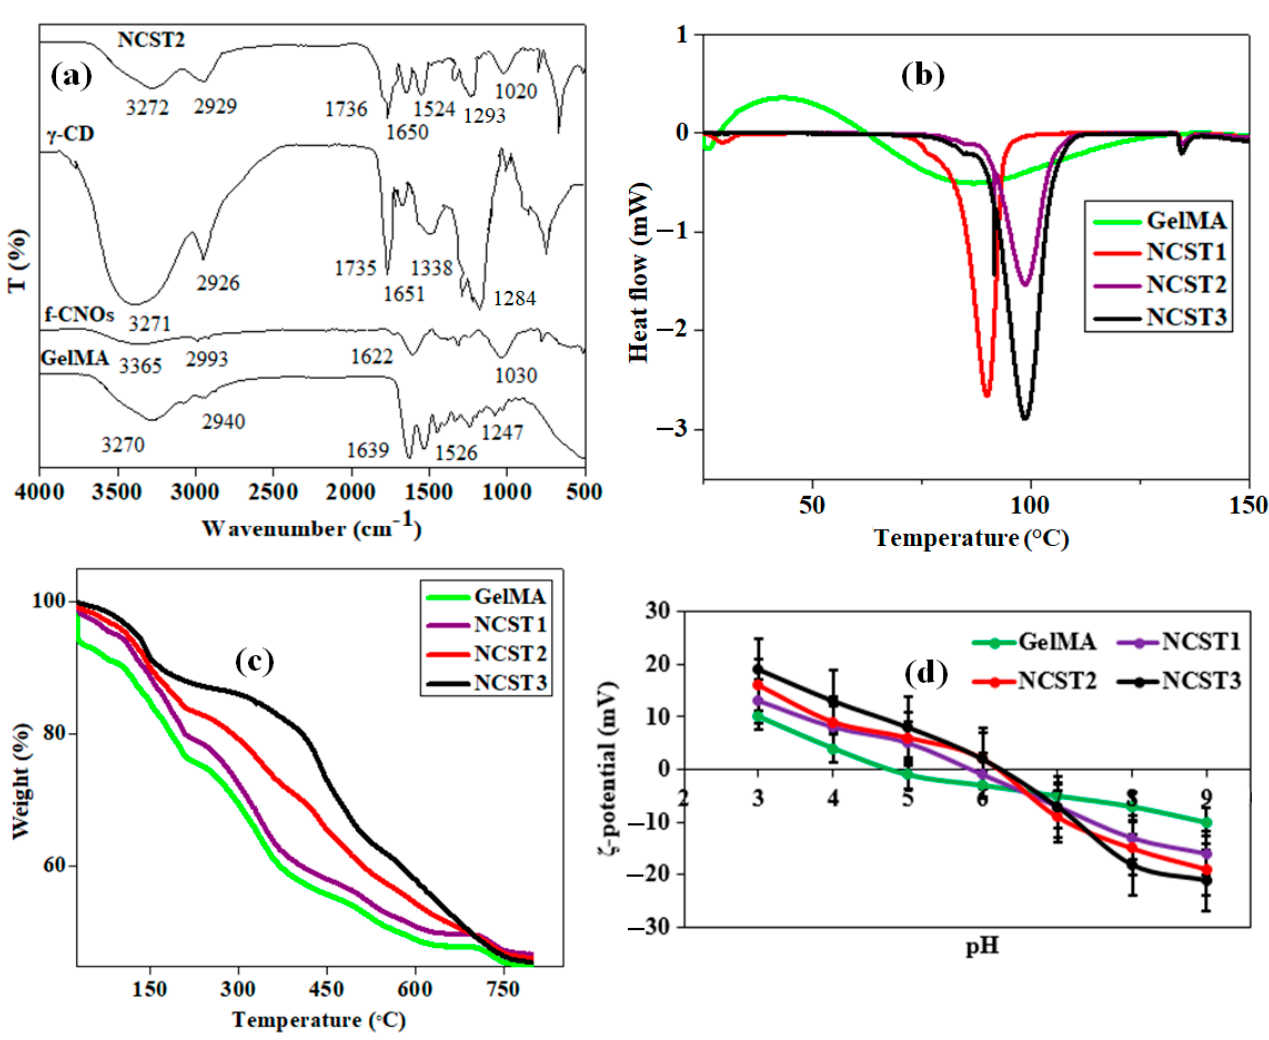
Figure 3. ( a ) FTIR, ( b ) DSC, ( c ) TGA, and ( d ) ζ -potential curves of pristine GelMA and NCST hydrogels, respectively.